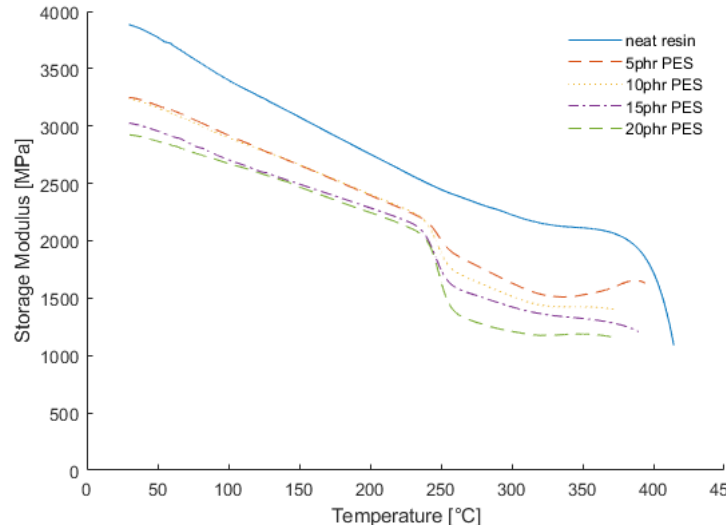
Figure 4. Storage modulus measured via dynamic measurements.